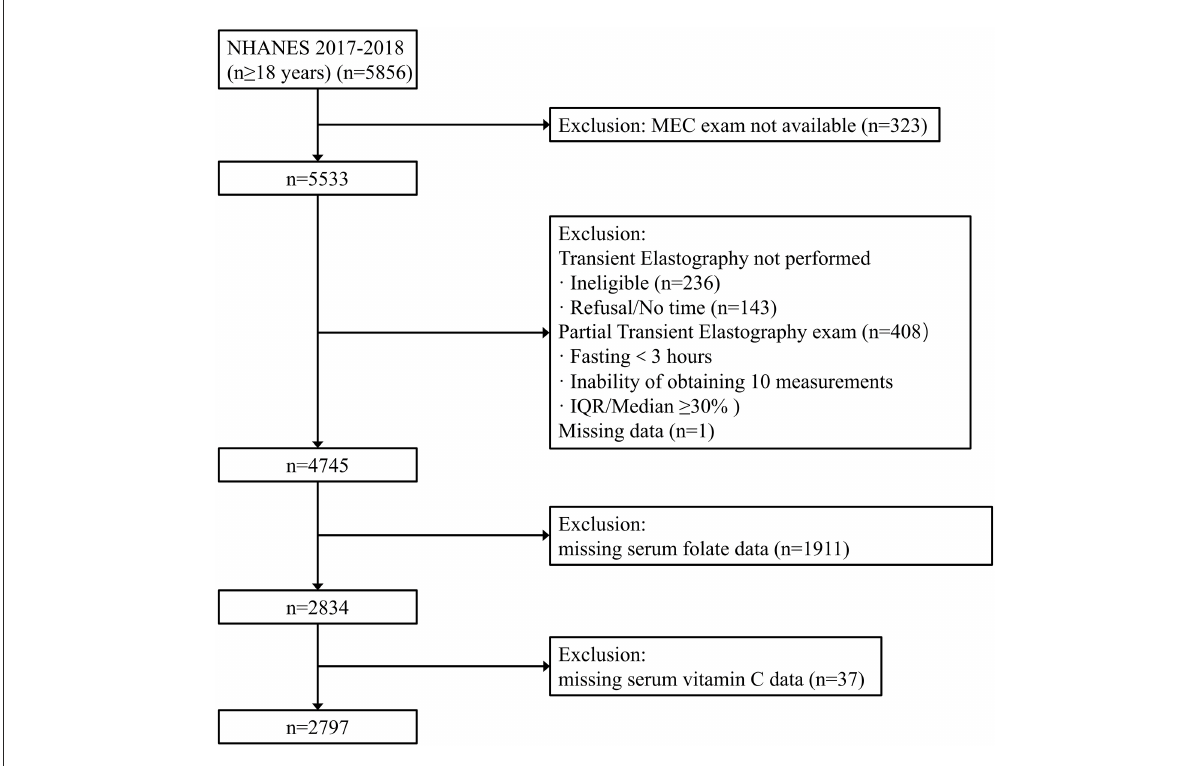
FIGURE1 Flow-chart of the MAFLD